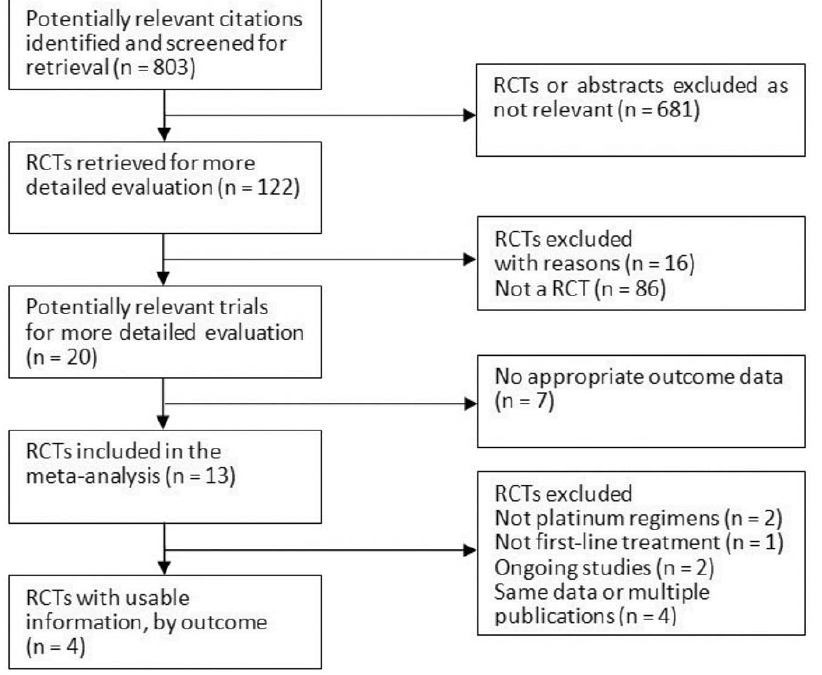
Figure 1. Procedures used for trial selection. Abbreviations: RCT, randomized controlled trial.